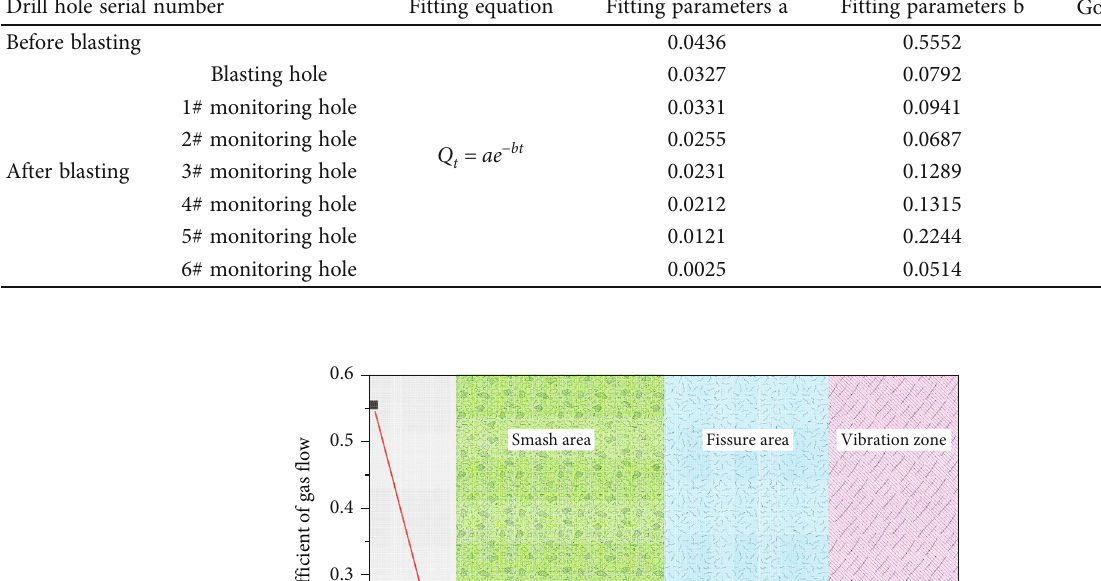
Table 2: Fitting equations for natural methane fl ow in di ff erent boreholes before and after blasting with time. Drill hole serial number